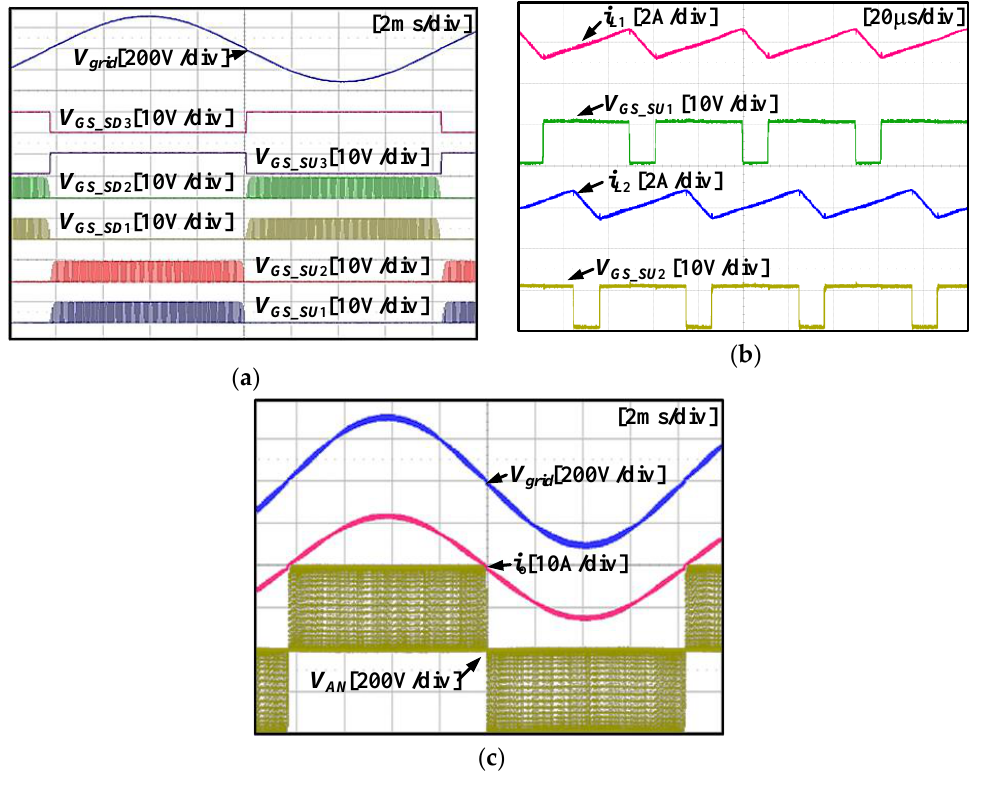
Figure 10. Experimental waveforms of proposed inverter, measured at V in = 400 V DC , V grid = 220 V AC /60 Hz, f s = 20 kHz, and P o = 2 kW: ( a ) gate input pulses, ( b ) V GS_SU1 , V GS_SU2 , i L 1 , and i L 2 , and ( c ) i o , V AN , and V gri d . (Figure 11) was measured at V in = 400 V DC , V grid = 220 V AC /60 Hz, 150 W ≤ P o ≤ 2 kW,